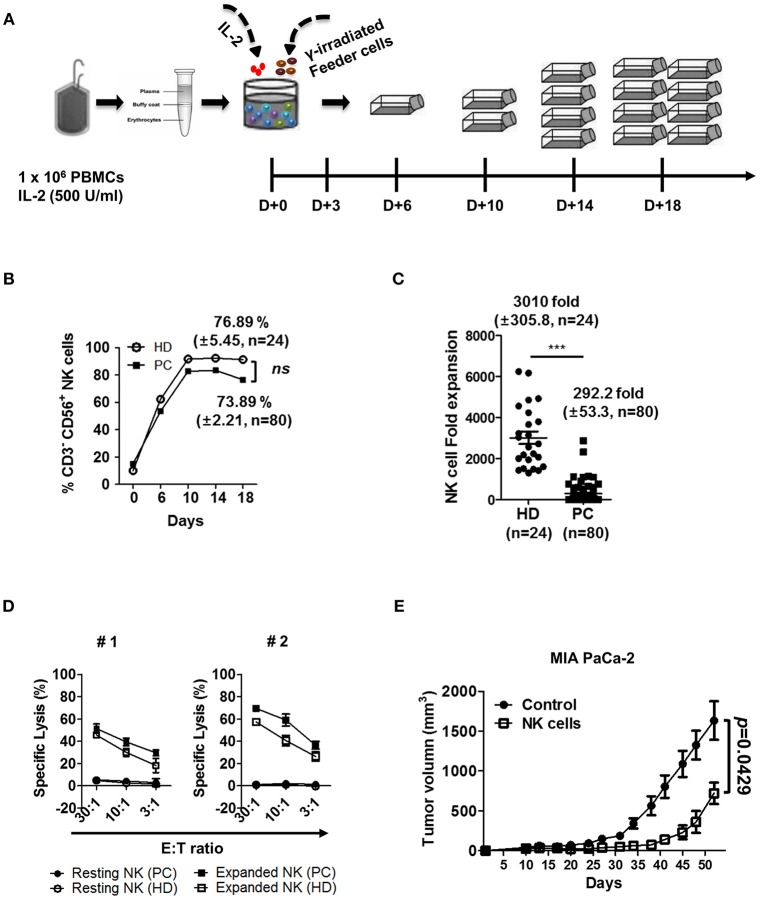
Ex vivo activated NK cells demonstrate strong anti-tumor cytotoxicity against autologous and allogeneic PDAC target cells. (A) Schematic diagram showing ex vivo expansion of NK cells. PBMCs were isolated from blood and cultured at a ratio of 1:0.5:0.5 with irradiated KL-1 and LCL feeder cell lines in the presence of 500 U/ml IL-2. (B) NK cell percentages in healthy donor and patients with PDAC are shown with respect to time. (C) Average fold changes of NK cells at day 18 for healthy donors and patients with PDAC are shown. (D) Standard 4-h 51Cr release assay was performed using autologous (PC) or allogeneic NK cells (HD) against autologous PDAC tumor targets. Target cells (#1, #2) used in these assays are patient-derived pancreatic cancer cell lines. Resting NK-PC (•), Resting NK-HD (°), Expanded NK-PC (■), Expanded NK-HD (□). Data shown here are representative of three independent experiments. (E) Xenograft mouse model was established by injecting MIA PaCa-2 tumor cells (1 × 107 cells/mouse) subcutaneously into NSG mice. Ten days after cancer cell injection, ex vivo expanded NK cells (1 × 107 cells/mouse) were injected intravenously every seven days. Tumor volume was measured by calipers every 3–4 days. Results shown are average tumor volumes offive mice per group ± SEM. Error bars represent ± SEM. Statistical differences between groups were calculated by Student's t-test (***p < 0.001).